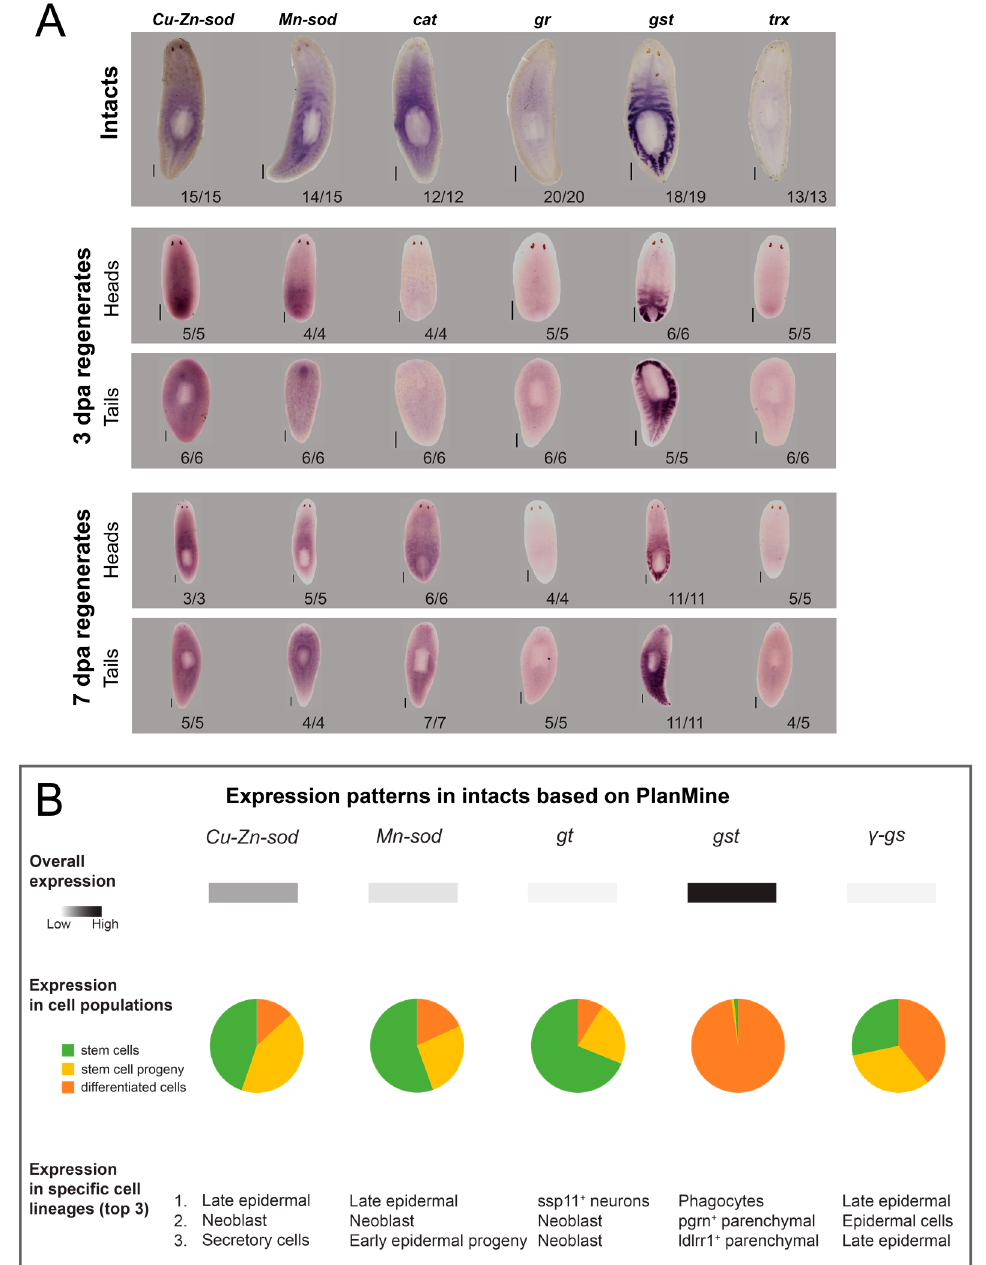
Figure 2. Localisation of major antioxidant systems in the planarian body. ( A ) Colorimetric in situ hybridizations of Cu-Zn-sod , Mn-sod , cat , gr , gst and trx in intact planarians and regenerating heads and tails 3 and 7 dpa. Scale bar represents 200 µm. ( B ) Expression levels of Cu-Zn-sod , Mn-sod , gr , gst and γ -gs in intact worms, based on transcriptome data deposited in PlanMine v3.0. (MPI-CBG, Dresden, Germany) ( sod : superoxide dismutase, cat : catalase, gr : glutathione reductase, gst : glutathione-S-transferase, γ -gs : γ -glutamylcysteine synthetase, trx : thioredoxin, dpa: days post amputation).